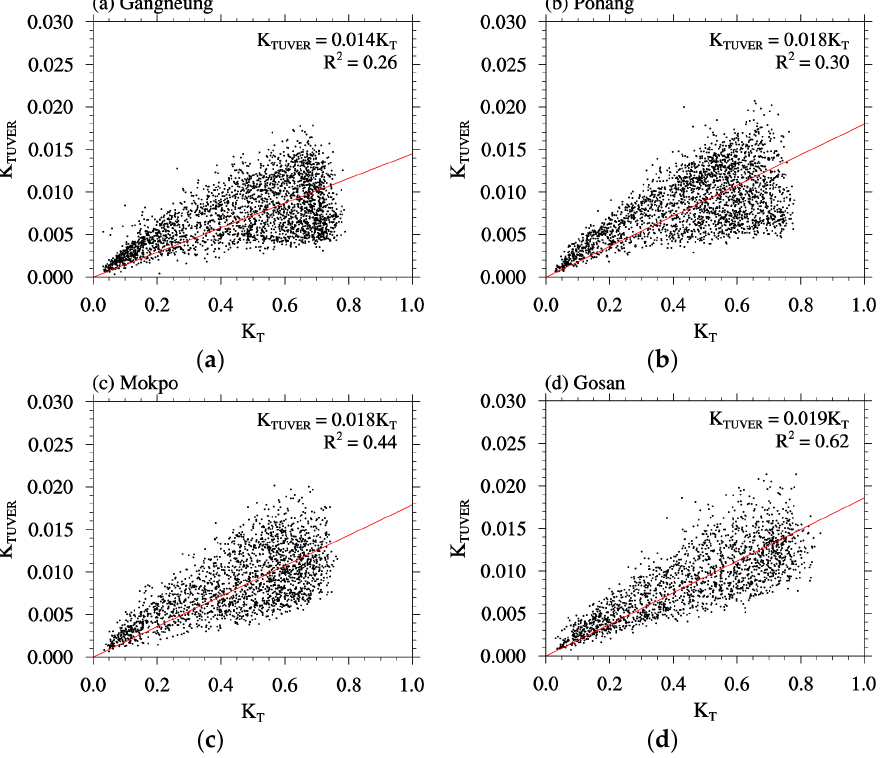
Figure 4. Relationship between K TUVER and K T at ( a ) Gangneung, ( b ) Pohang, ( c ) Mokpo, and ( d ) Gosan. The red line is the linear regression line.